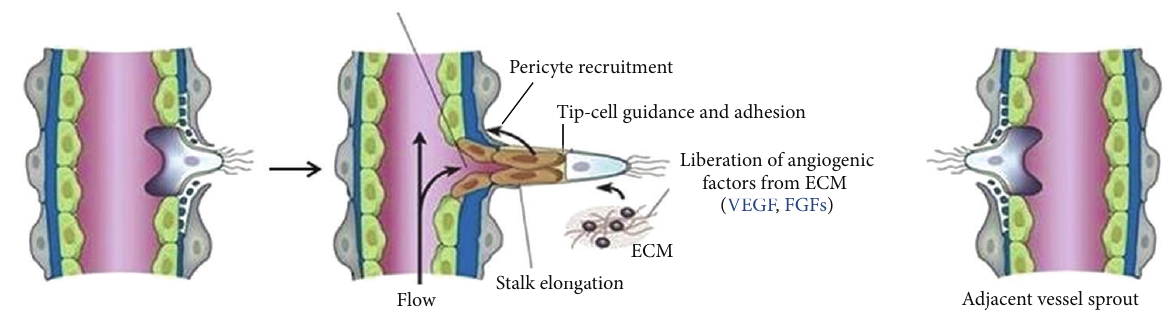
Figure 1: Angiogenetic sprouting: after stimulation with angiogenic factors, the quiescent vessel dilates and an endothelial cell tip cell is selected. Stalk cells behind the tip cell proliferate, elongate, and form a lumen, and sprouts fuse with an adjacent vessel sprout to establish a perfused neovessel, (from [8],